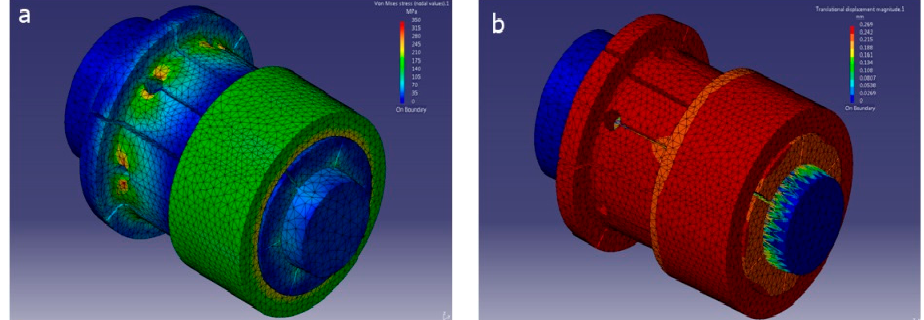
Figure 15. Special expanding mandrel dimensions: (a) collet, (b) acting system.